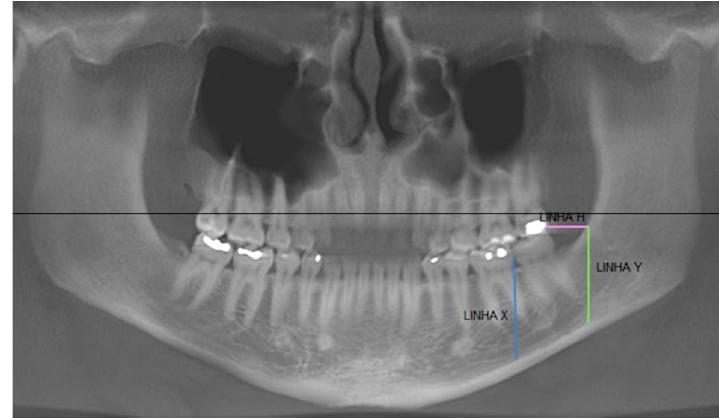
Figure 2- CBCT panoramic reformation showing the positions of Lines X, H and Y, which represent the limits of interest in the evaluation